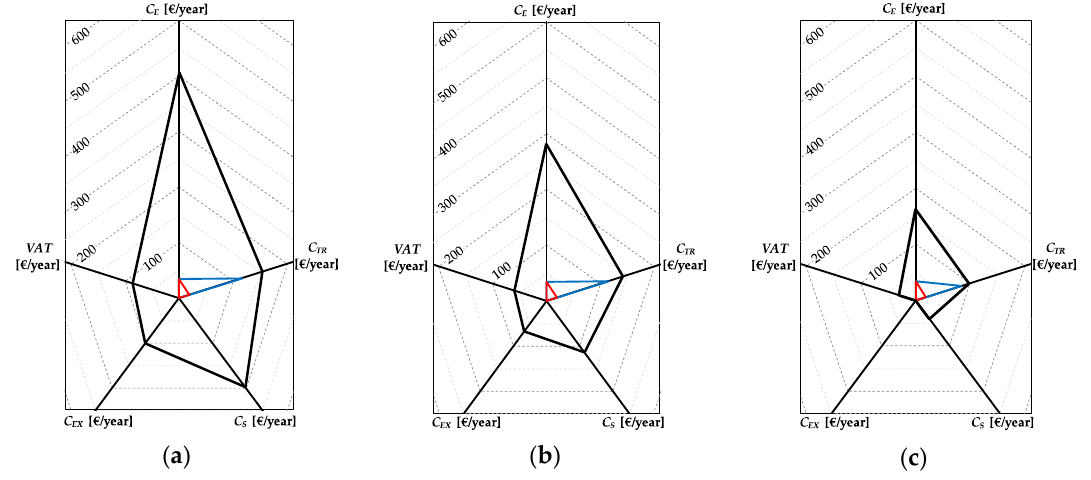
Figure 10. Bill components C E , C TR , C S , C EX , and VAT represented in a five-axes plan. ( a ) Scenario A, passive customer; ( b ) Scenario B, active end-user solely with PV generation; ( c ) Scenario C, active end-users with PV generation and storage system.